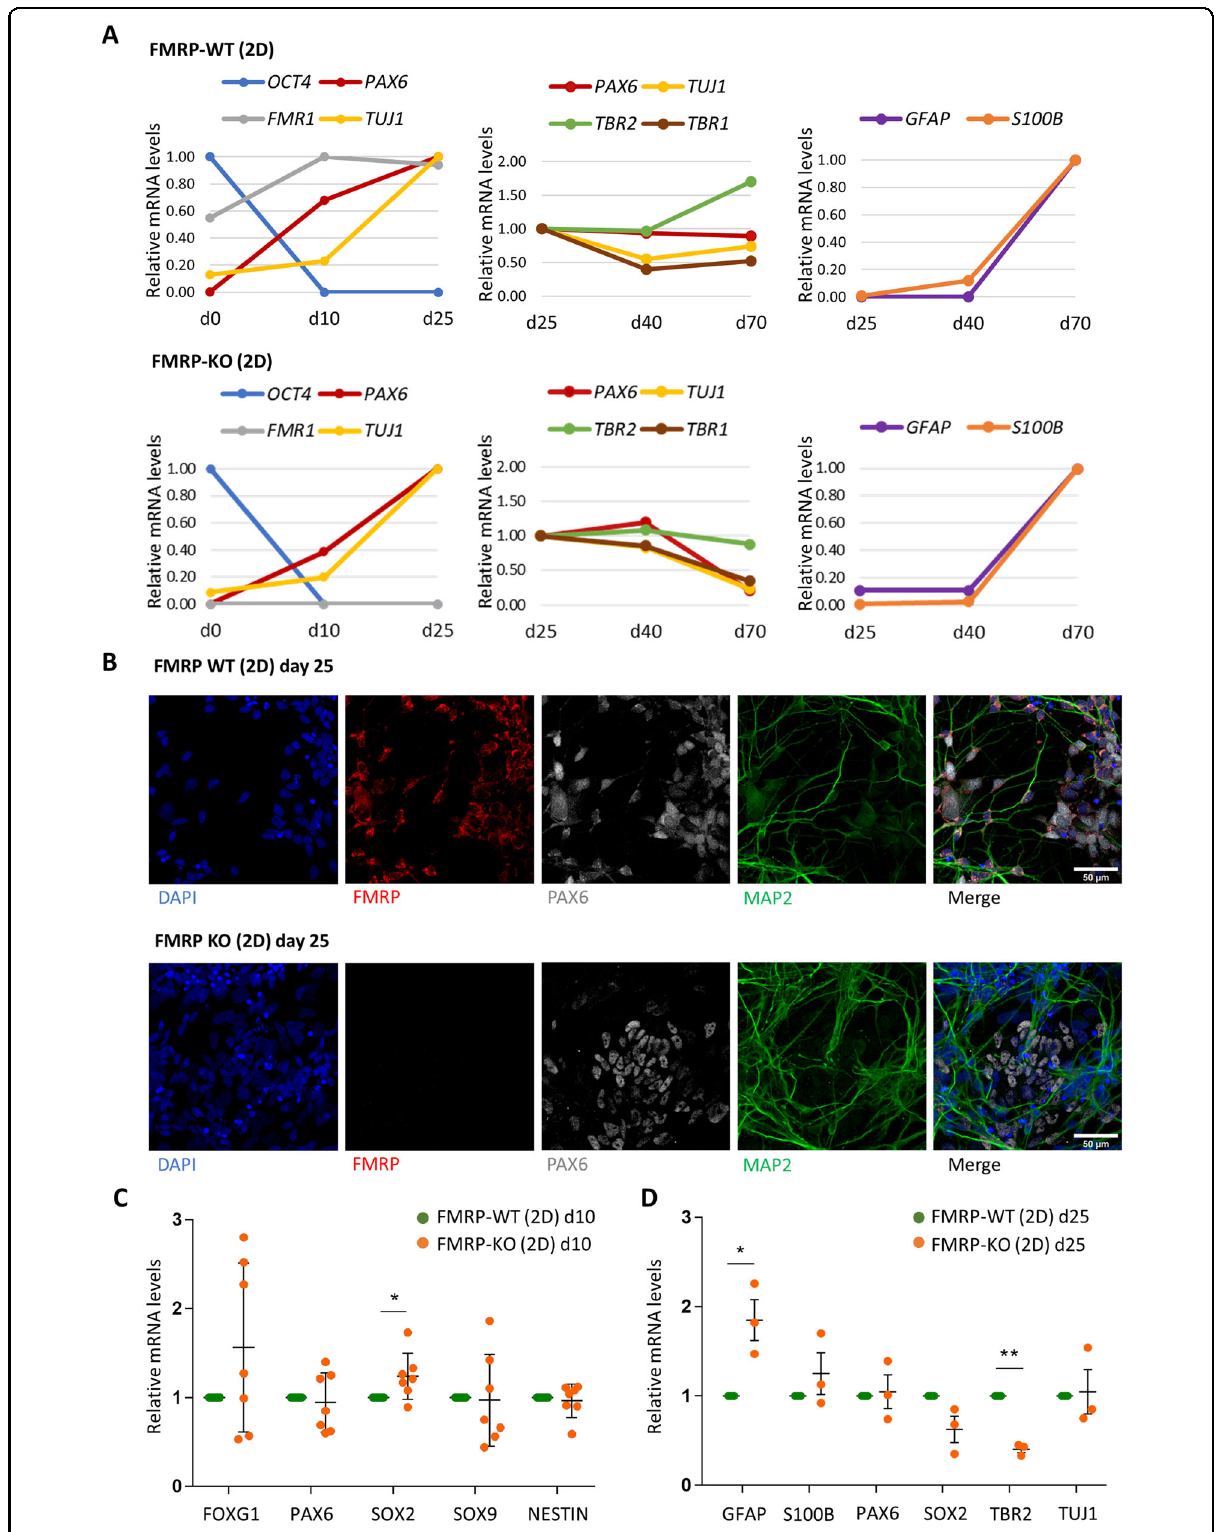
Fig. 2 Differentiation of FMRP knock-out and isogenic control hiPSCs into cortical neurons. A Real-time qRT-PCR analysis of the indicated markers expression in differentiating FMRP-WT (top) and FMRP-KO (bottom) cells at the indicated time points. B Representative images of immunostaining for FMRP (red), PAX6 (white), and MAP2 (green) expression in FMRP-WT and FMRP-KO cells at day 25. Scale bar: 50µm. C , D Real-time qRT-PCR analysis of the indicated markers expression in FMRP-WT and FMRP-KO cells at day 10 ( C )and 25 ( D ) of differentiation (FMRP-KO vs FMRP-WT; Student ’ s t test; paired; * p <0.05, ** p <0.01; n = 3